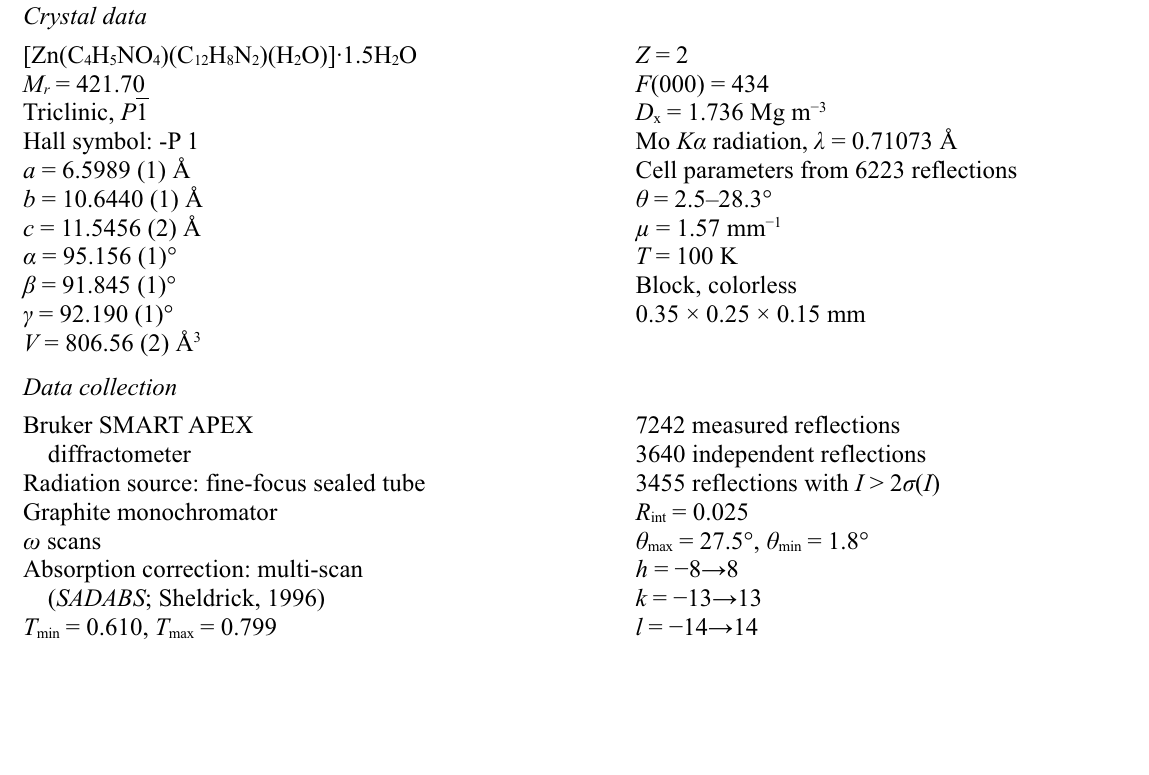
Figure 1 Thermal ellipsoid plot (Barbour, 2001) of Zn(H atoms are drawn as spheres of arbitrary radius. The O3 w water molecule, which lies on a general position, has 0.5